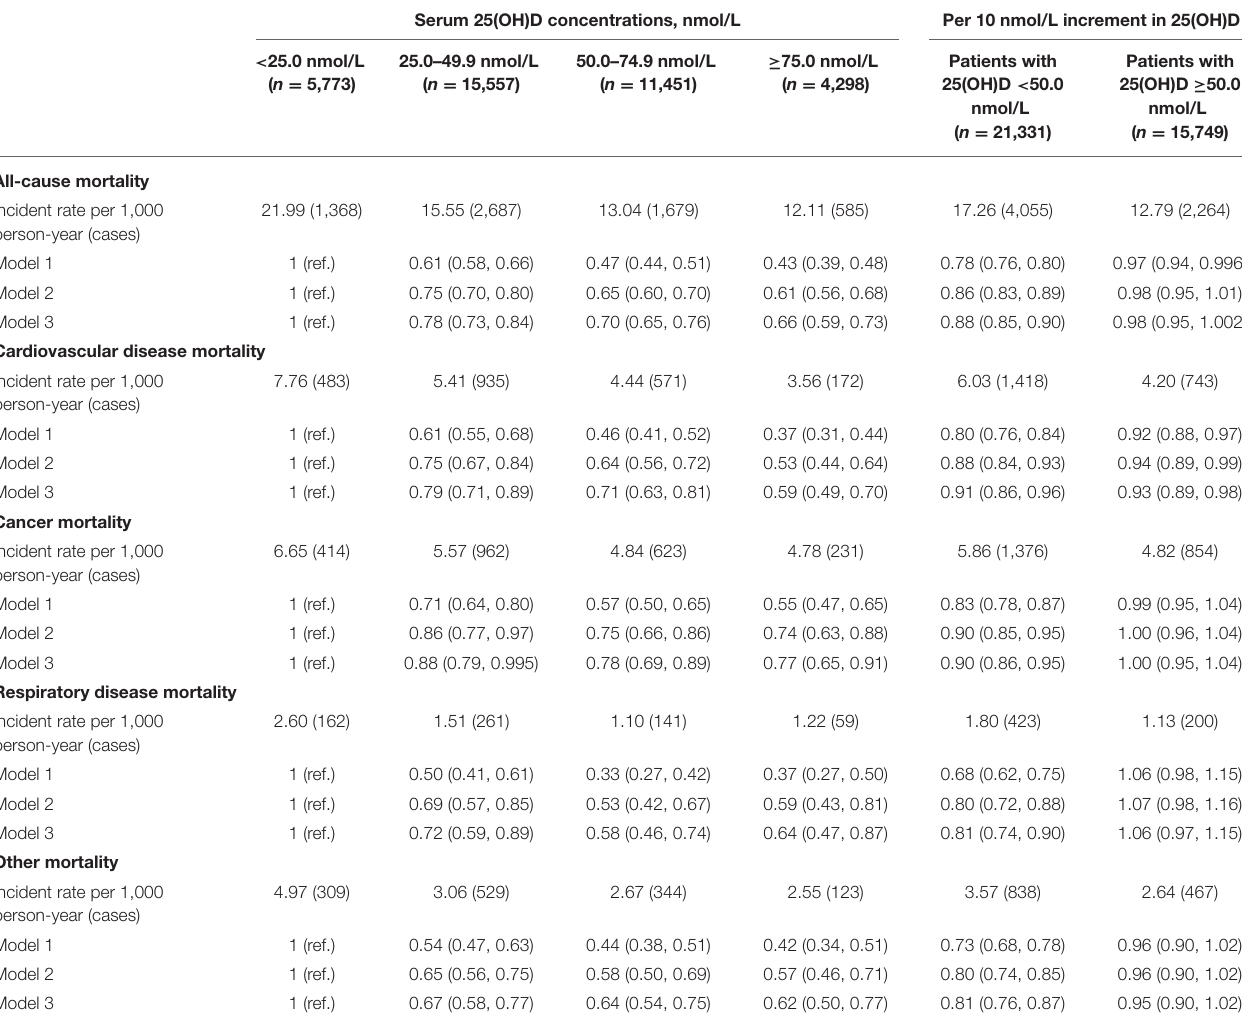
TABLE 3 | Associations of serum 25(OH)D concentrations with all-cause and cause-specific mortality among 37,079 CVD